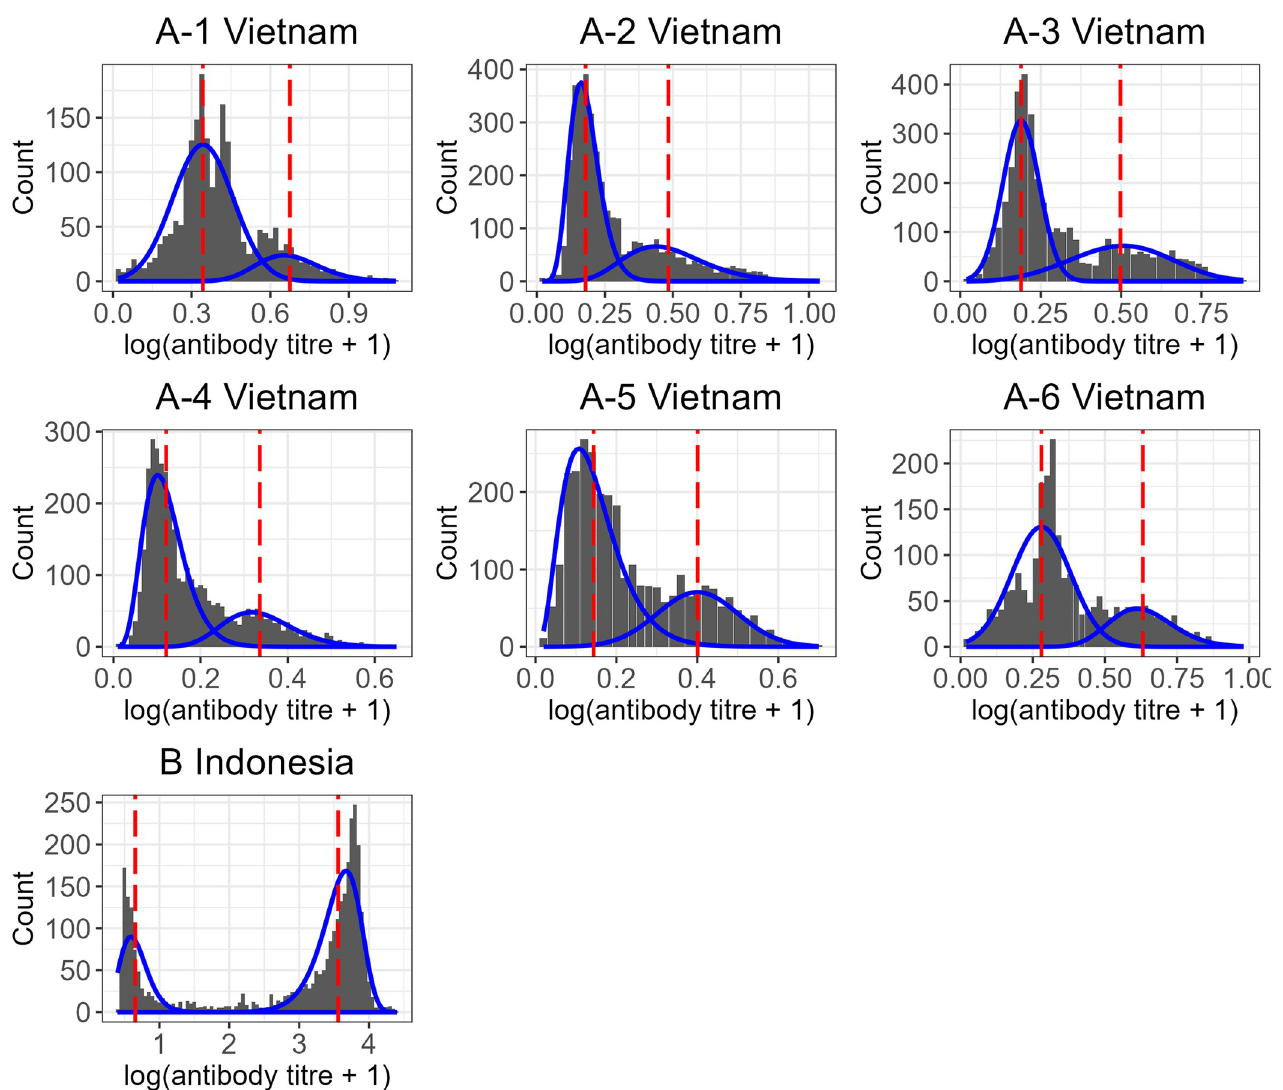
Fig 3. Mixture model fitted to the Vietnamese (A1:A6) and Indonesian (B) datasets. The distribution of log(titre+1) is shown in dark grey, the fitted mixture model is shown in blue, and the red dashed lines represent the mean antibody titre of each component of the fitted mixture model ( μ s and μ I for the seronegative and seropositive components respectively). Note that the y-axis limits differ for each panel.